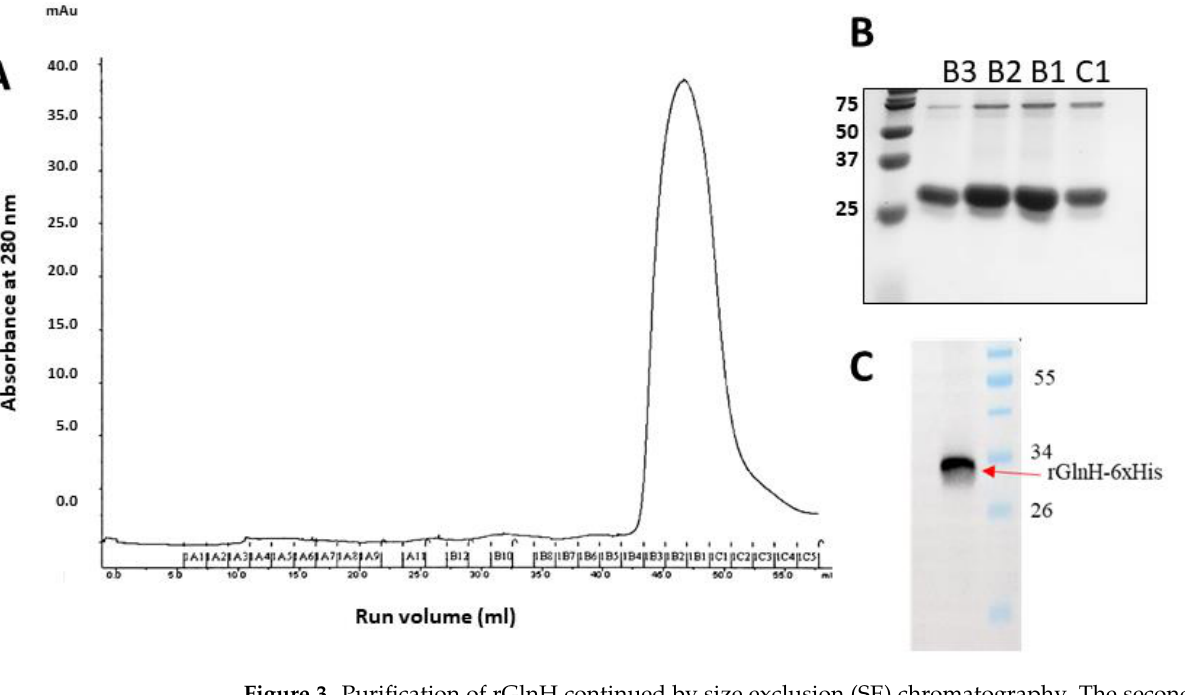
Figure 3. Purification of rGlnH continued by size exclusion (SE) chromatography. The secondary purification of expressed and affinity-purified rGlnH using a HiLoad ® 16/600 Superdex ® 75 pg column 16/60. Fractions collected in 96-well plate representative of large peak at a run volume (mL) 43–55 mL ( A ) and the purity of fractions B3, B2, B1 and C1 was visualised on 12% SDS gel ( B ). ( C ) Western blot confirms presence of His-tagged rGlnH.